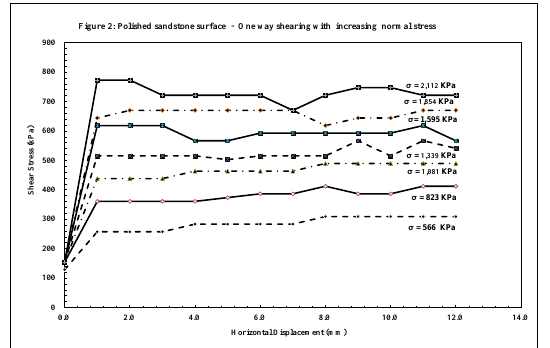
Figure 2: Horizontal displacement versus shear stress for polished sandstone core under different normal stresses